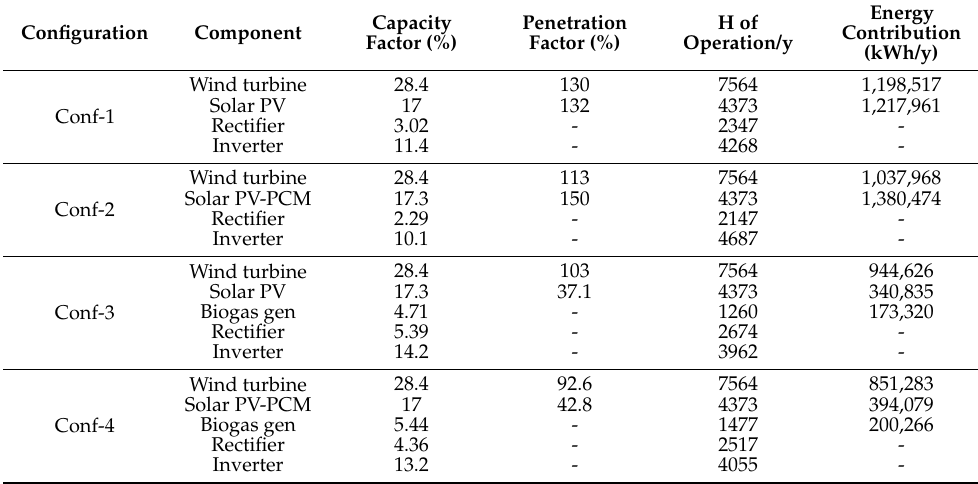
Figure 10. Monthly energy contribution of Conf-4. Table 7. Energy analysis of hybrid energy